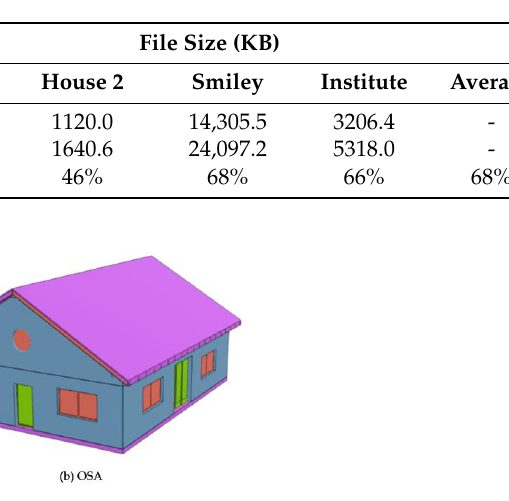
Figure 17. House 1 model generated by ( a ) OCCT-OSA and ( b ) OSA.